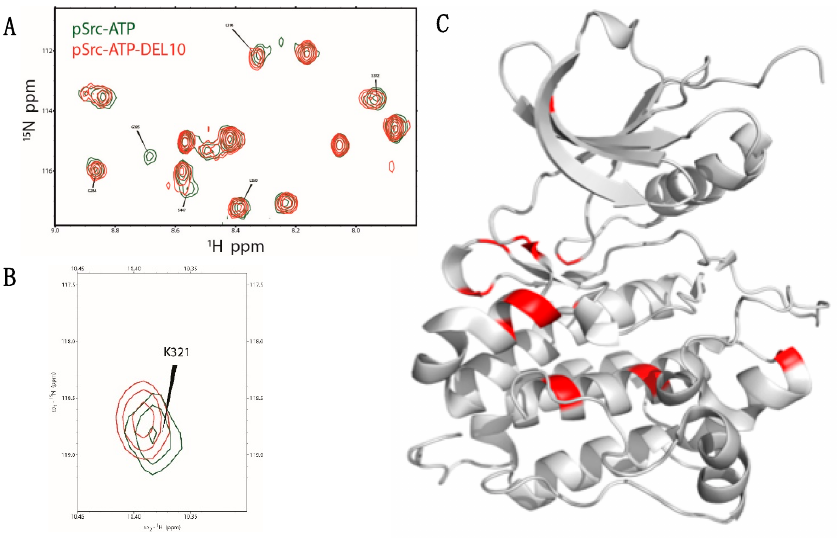
Figure 7. NMR analysis of SrcDEL10 binding. ( a ) Overlay of 15 N-HSQC spectra of the phosphorylated Src catalytic domain in the presence of ATP (green) or ATP and SrcDEL10 (red). Ligand concentrations are near saturation based on estimated K m values. A portion of the spectrum showing significant changes is highlighted. See Figure SX for full spectrum. ( b ) A portion of the spectrum shows significant chemical shift perturbation of K321 in the presence of SrcDEL10 . ( c ) Chemical shifts with large changes upon addition of SrcDEL10 are mapped (red) to the ribbon drawing of the Src kinase domain (PDB ID: 1Y57) [58].